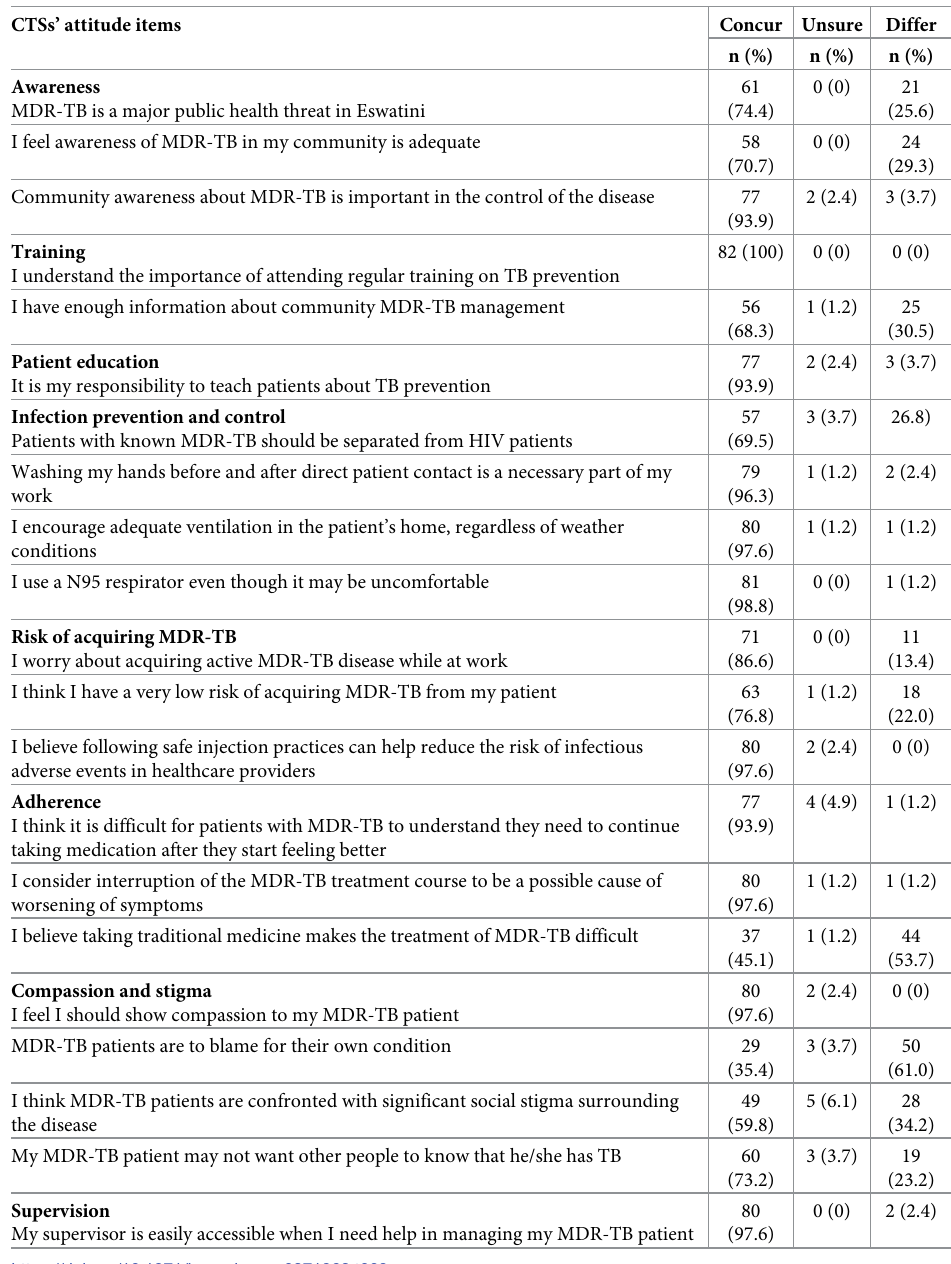
Table 3. CTSs’ attitude towards